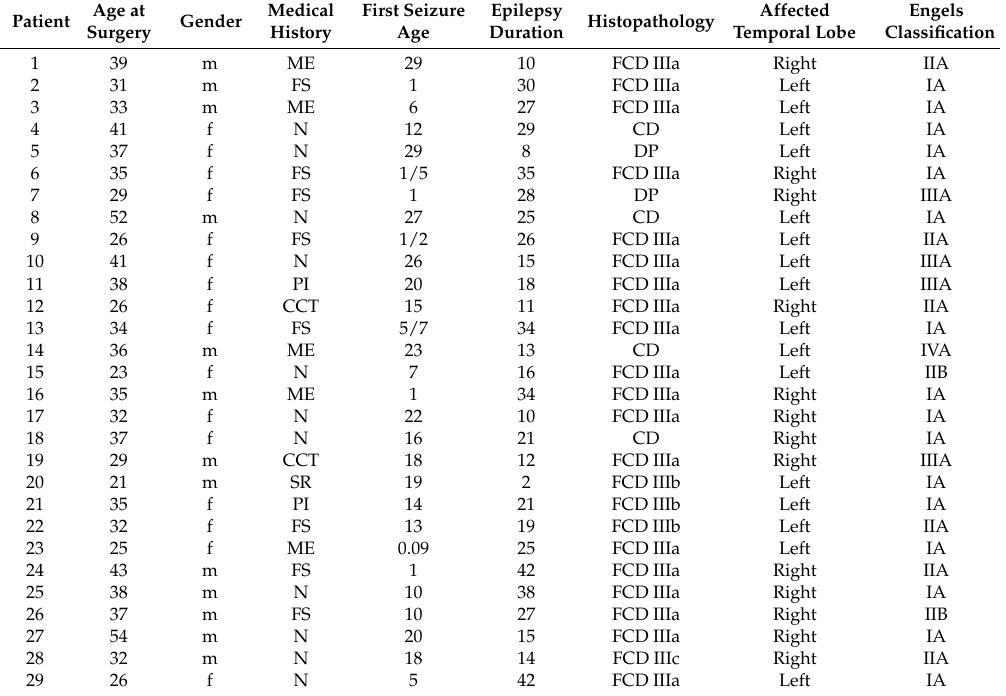
Table 1. Ageat surgery, gender, medical history, age of first seizure, epilepsy duration, histopathology, related temporal lobe to epileptogenic zone, Engels classification. ME (meningo-encephalitis), FS (febrile seizure), N (None), PI (perinatal incident), CCT (cranial cephalic trauma), SR (speech retardation). FCD (focal cortical dysplasia) CD (chronic damage), DP (dual pathology).